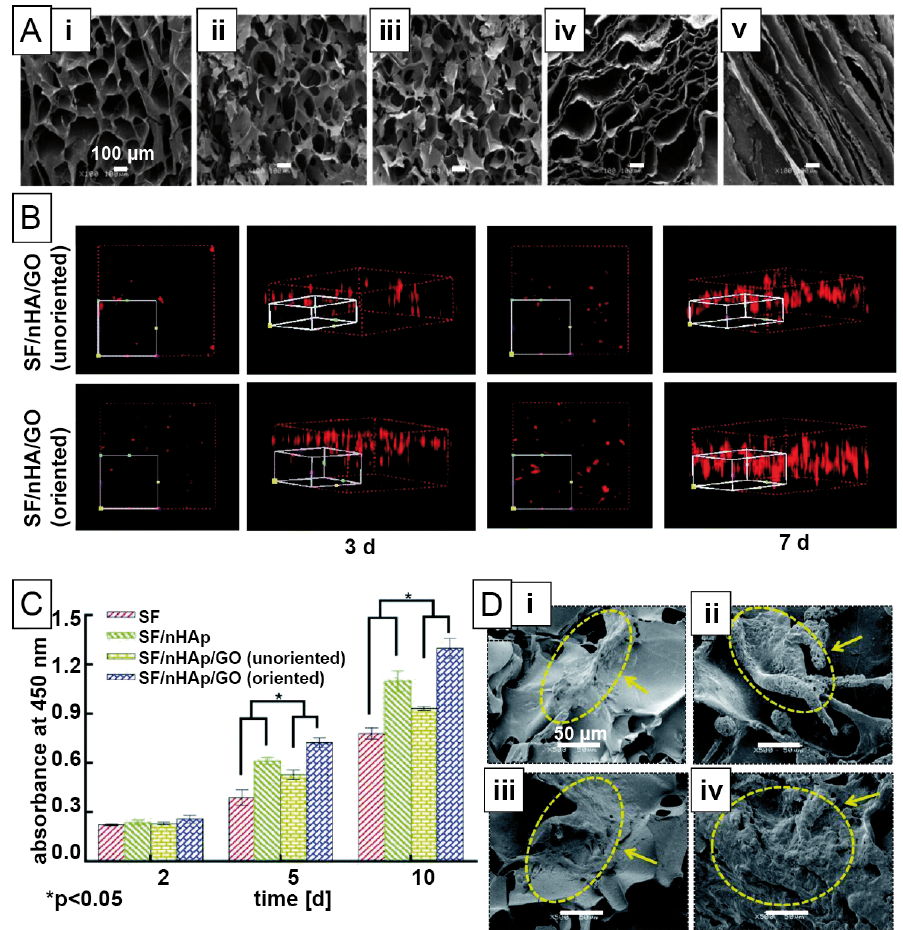
Figure 8. ( A ) Scanning electron microscopy images of lyophilized foam-like scaffolds with different orientation made of plain Bombyx mori silk fibroin ( i ), foams loaded with hydroxyapatite nanoparticles ( ii ), foams loaded with hydroxyapatite and graphene oxide nanoparticles in unoriented structures ( iii ), with directional structuring in cross-section ( iv ) and in longitudinal ones ( v ). ( B ) 3D Confocal microscopy images of HUVEC cells in unoriented and oriented foams loaded with hydroxyapatite nanoparticles and graphene oxide nanoparticles after 3 and 7 days. Scale bar not indicated. ( C ) Cell viability assay for bone mesenchymal stem cells after 2, 5 and 10 days. ( D ) Scanning electron microscopy images of bone mesenchymal stem cells in lyophilized foam-like scaffolds after 10 days for ( i ) silk fibroin, ( ii ) foams loaded with hydroxyapatite nanoparticles loaded with hydroxyapatite and graphene oxide nanoparticles without ( iii ) and with ( iv ) directional structuring. SF = silk fibroin, nHA = hydroxyapatite nanoparticles, GO = graphene oxide. Reprinted and adopted with permission from ref. [113]. Copyright 2020 Royal Society of Chemistry.